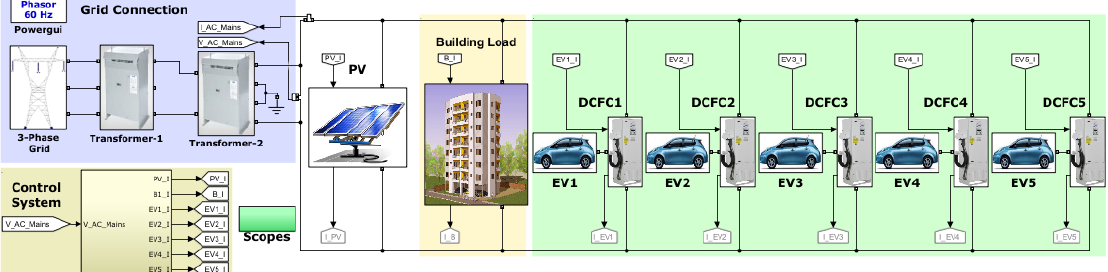
Figure 10. Simulink model of multi‒vehicle‒based vehicle‒to‒building/grid (V2B/V2G).